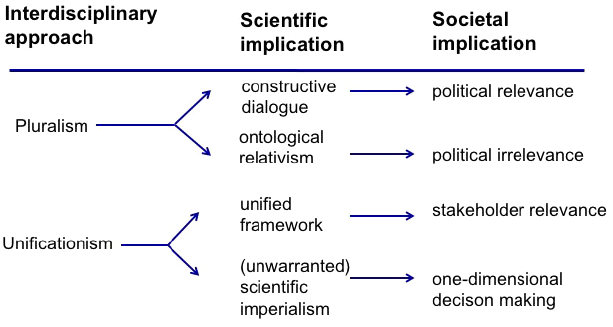
Fig. 1 . Scientific and societal implications of two approaches to